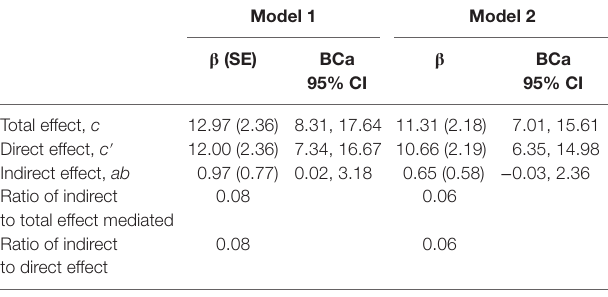
Model 1: unadjusted mediational model. Model 2: adjusted for age, sex, and monthly family income. Number of bootstrap samples for bias-corrected bootstrap confidence intervals: 5,000. β , unstandardized coefficient; BCa, bias accelerated and